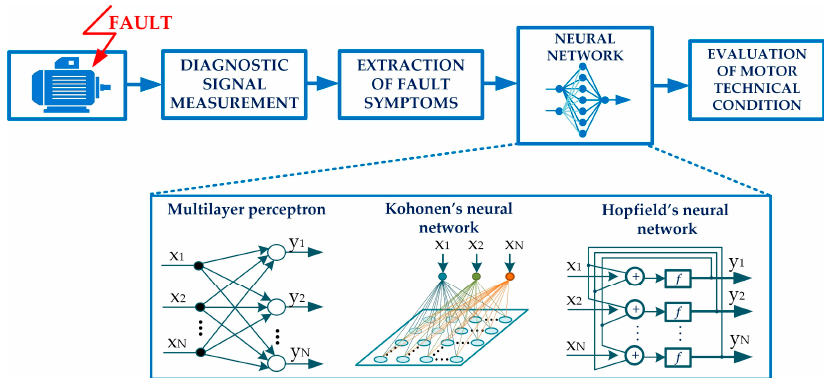
Figure 2. Illustration of the IM damage detection process using axial flux measurement and different NN